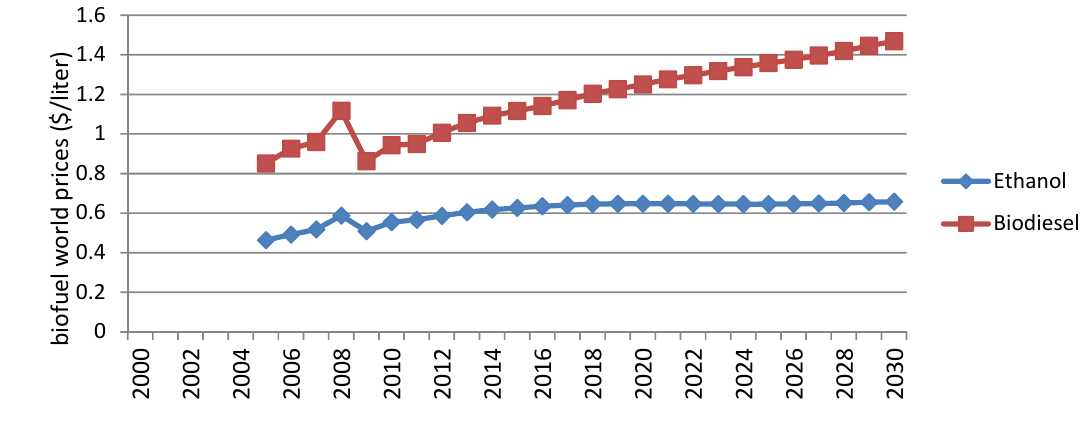
Figure 8. World prices of ethanol and biodiesel under